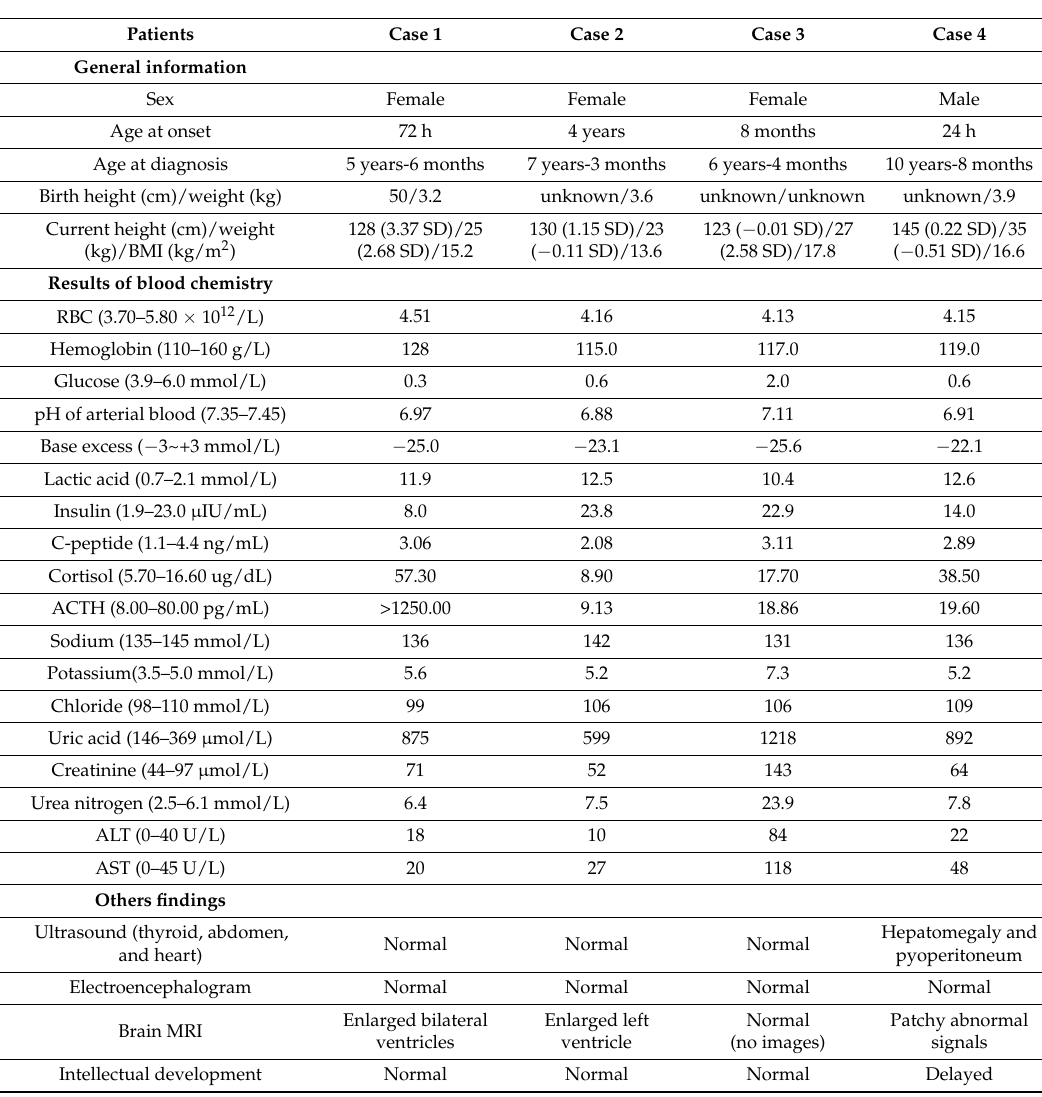
Table 1. Summary of clinical findings of the